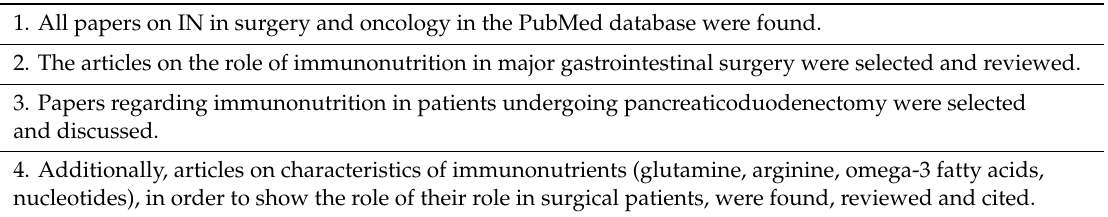
Table 1. Search Strategy of the Literature